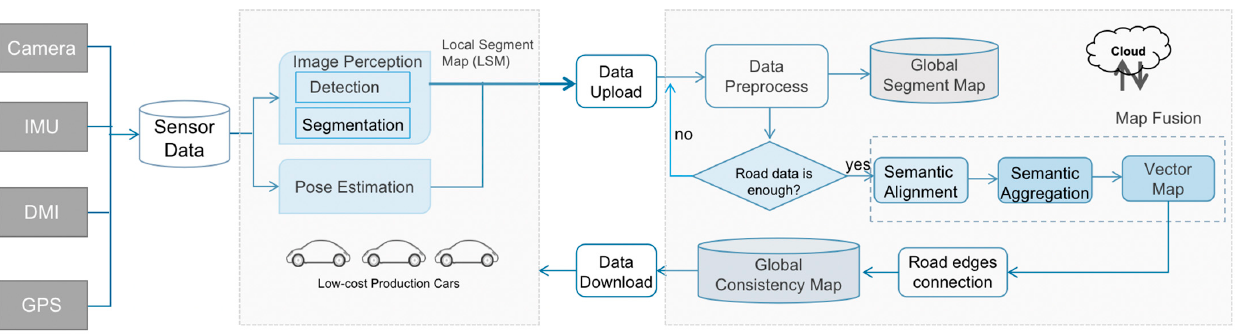
Figure 1. The architecture of HD mapping system. Low-cost sensors, such as a monocular camera, an inertial measurement unit (IMU)/ global positioning system (GPS), and a wheel encoder, are used to collect data on-board the vehicle. Semantic elements, including lane lines, ground arrows, road stop lines, traffic signs, electrical poles, etc., are extracted from monocular vision. The ego-motion, estimated by the IMU and wheel encoder, is projected onto the 3D world coordinate system to form a local segment map (LSM) using semantic splicing. The global absolute pose of the vehicle can be estimated through GPS/IMU/wheel encoder fusion processing and then uploaded to the cloud